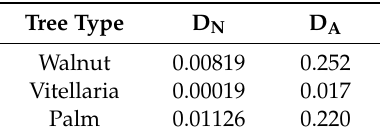
Table 4. Densities expressed as the number of trees per unit area (D N ) and as the area of trees per unit area (D A ) for walnut, palm, and vitellaria